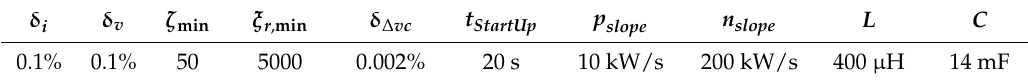
Table 1. Chosen values of the Maximum Power Point Tracking sizing